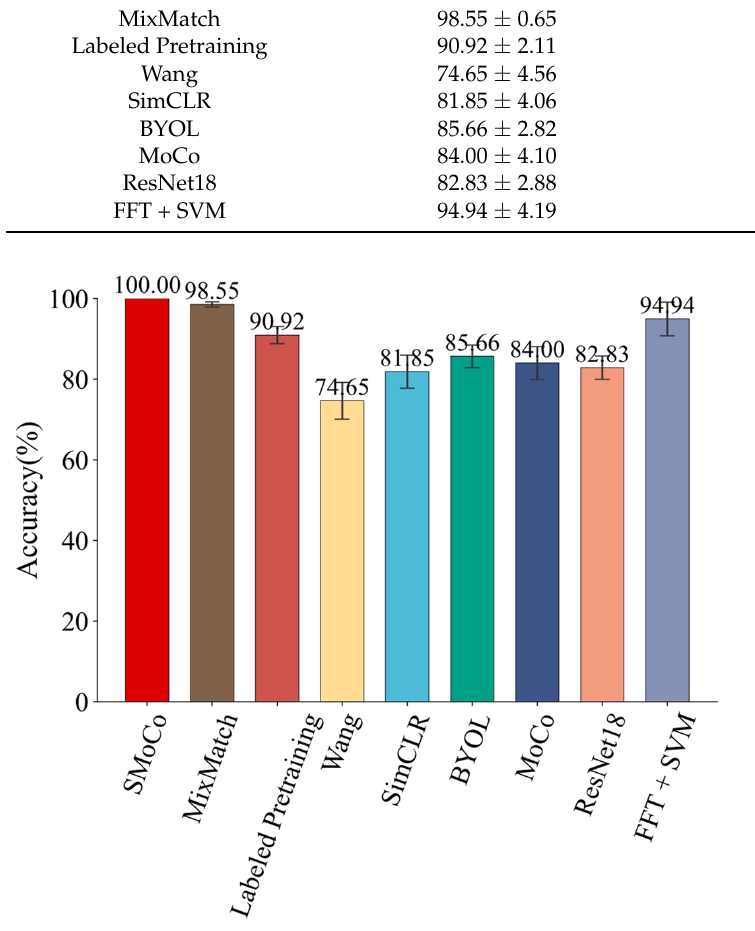
Figure 15. Comparison of diagnostic results on dataset 3 under 3 samples per class.